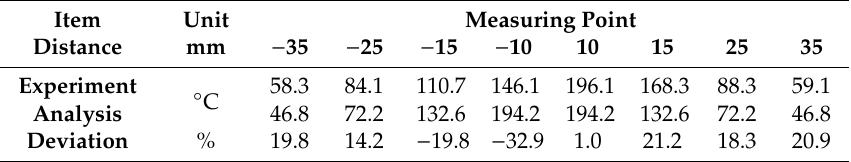
Figure 11. Heat transfer analysis results and experiment results: ( a ) Butt FSW; ( b ) fillet joint FSW. Table 6. Comparison of maximum displacements in x-direction [mm].